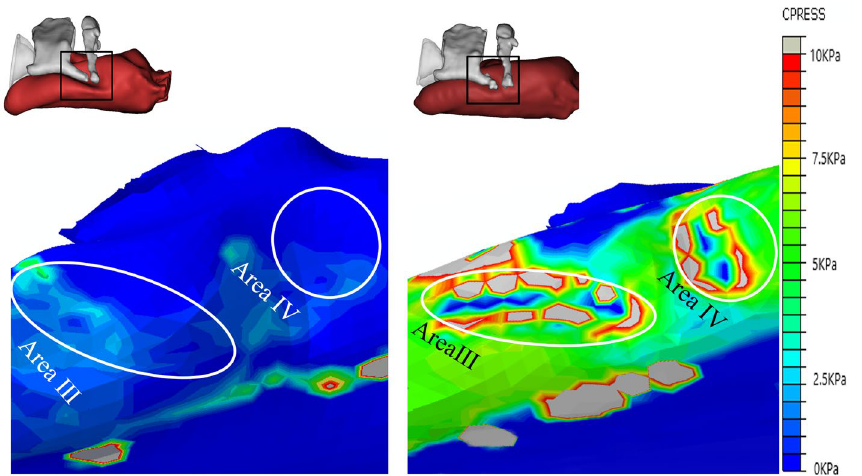
Figure 8. The pressure on laryngopharynx mucosa of PB-LMA50 (left) and PB-LMA100 (right). Areas III–IV show the impact of the super horns of the thyroid cartilage (Bone II), and the hyoid bone (Bone III), squeezing the mucosa from the sides. The peak MP magnitudes are 5.2 kPa (Area III, 9 mmHg), 21.7 kPa (Area III, 45 mmHg), 3.9 kPa (Area IV, 9 mmHg) and 14.9 kPa (Area IV, 45 mmHg), respectively.